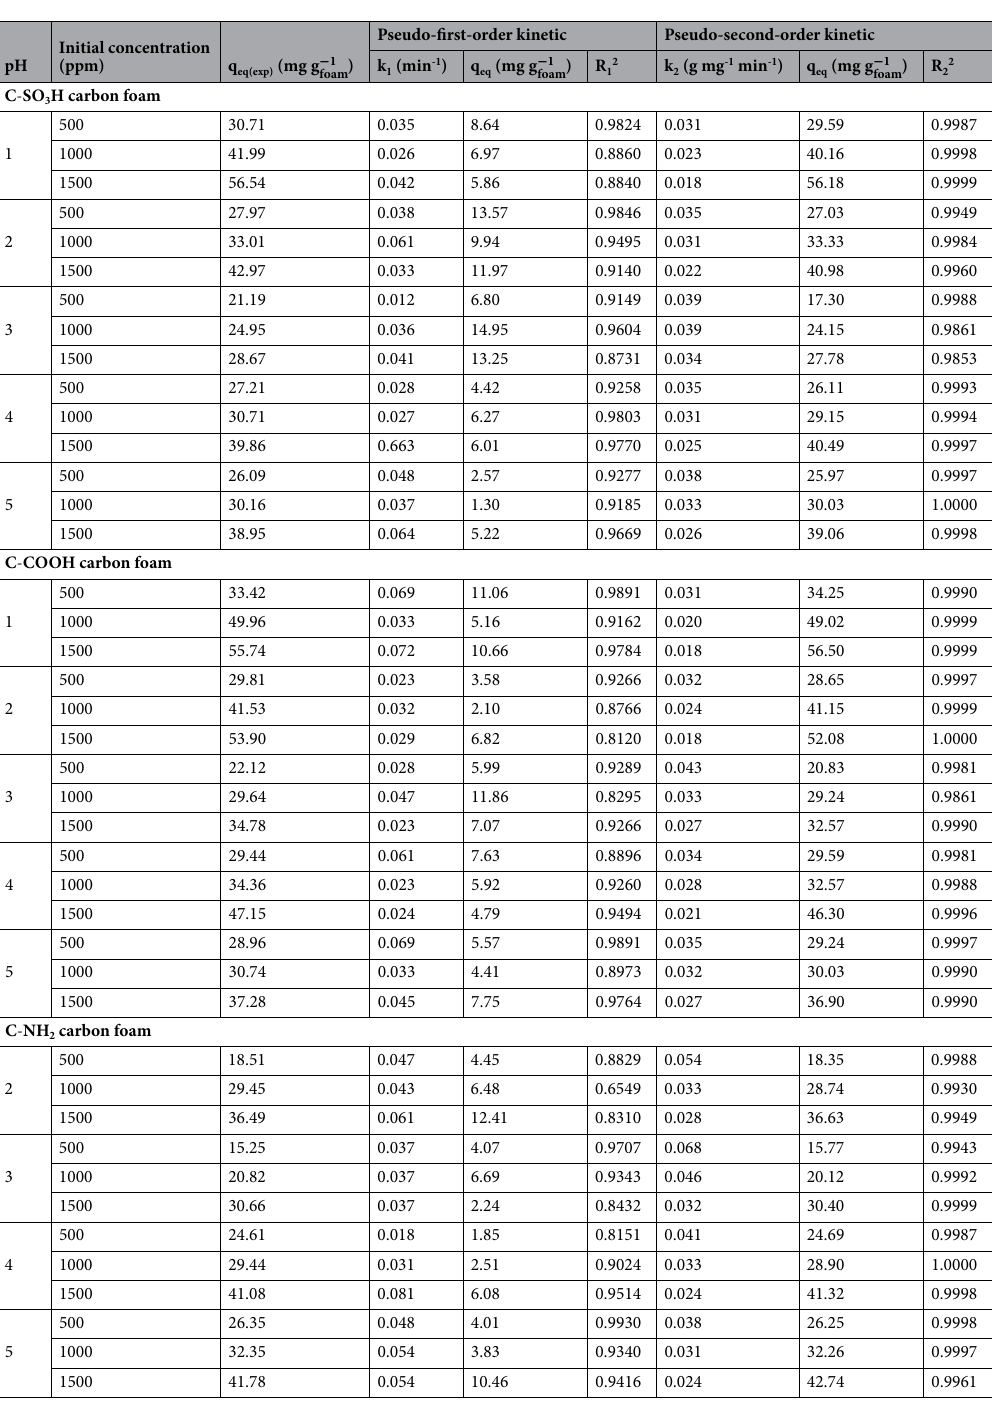
Table 3. Kinetic parameters of pseudo-first order and pseudo-second order kinetic models for Cu(II) adsorption onto functionalised carbon